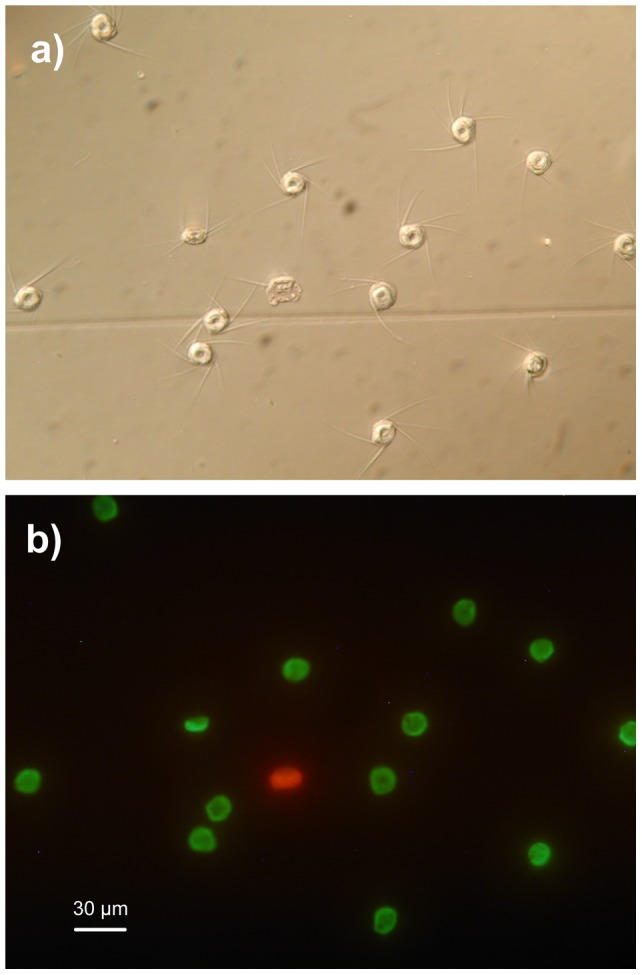
Stained freshwater crayfish sperm cells released from spermatophores (40× magnification).a) Phase contrast microscopy: note the radial nuclear arms or spikes spreading out from the sperm cells at activation; b) Fluorescence microscopy: the same sperm cells under fluorescence light with blue excitation filter (λ = 450–480 nm); living sperm with intact cellular membranes are green, while dead sperm are red.